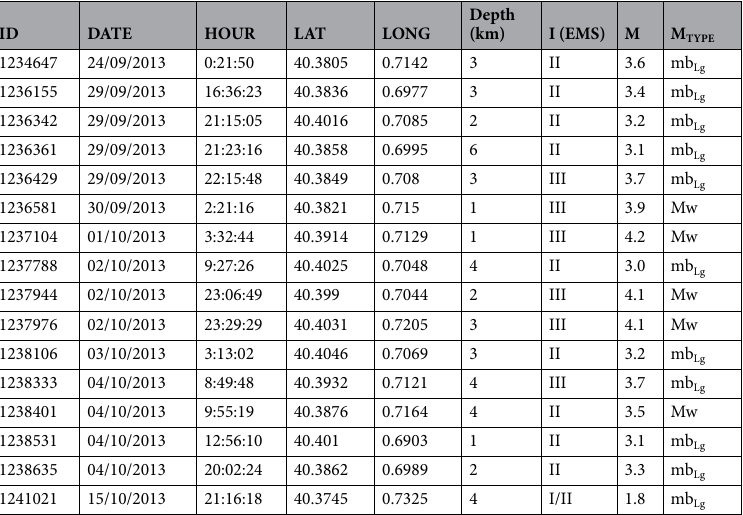
Table 1. Events occurred after the injection with an assigned intensity value